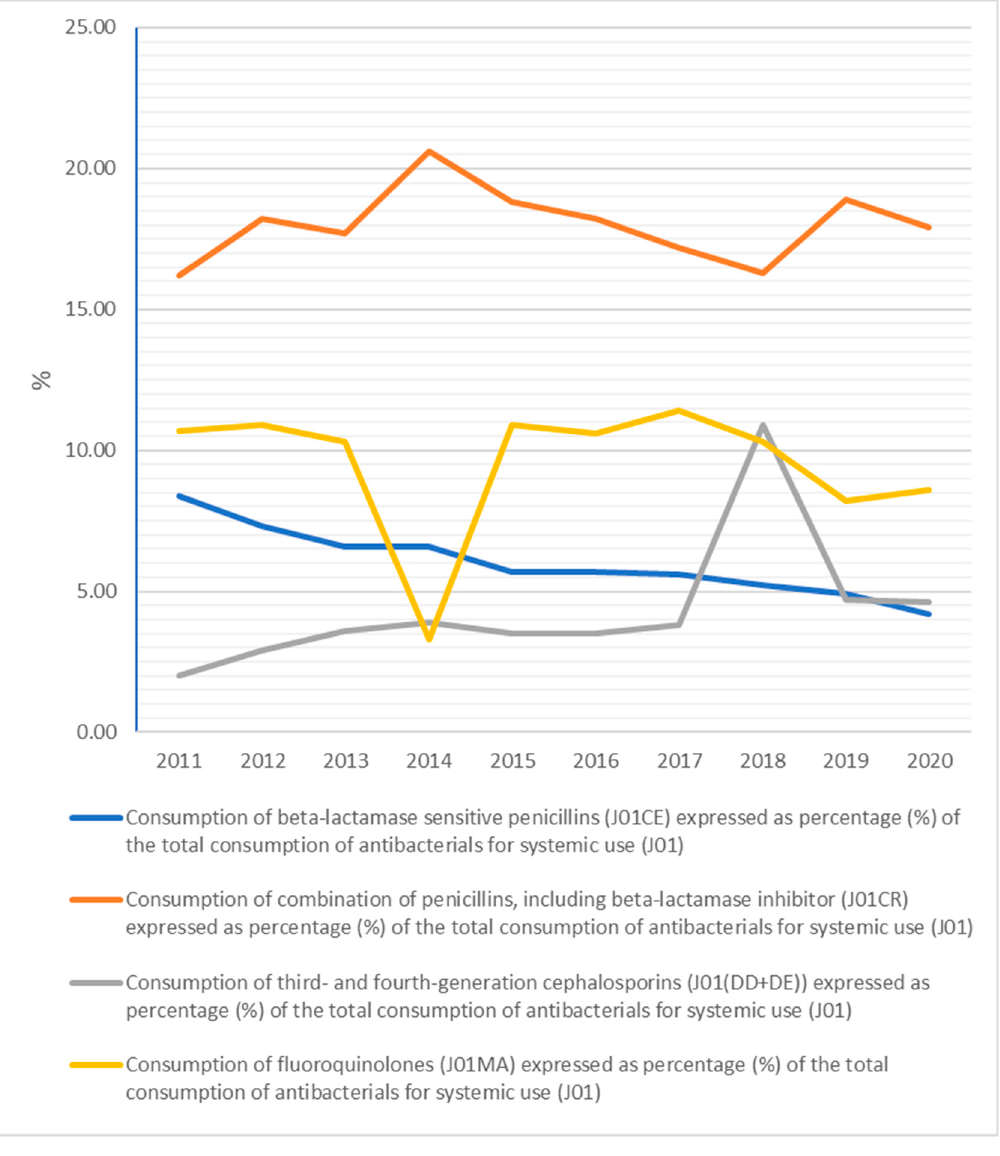
Figure 6. Quality indicators related to the relative consumption of antibiotics in the community from 2011 to 2020. The ratio of the consumption of broad-spectrum to the consumption of narrow-spec- trum penicillins, cephalosporins and macrolides decreased from 14.98 in 2011 to 13.38 in 2020.